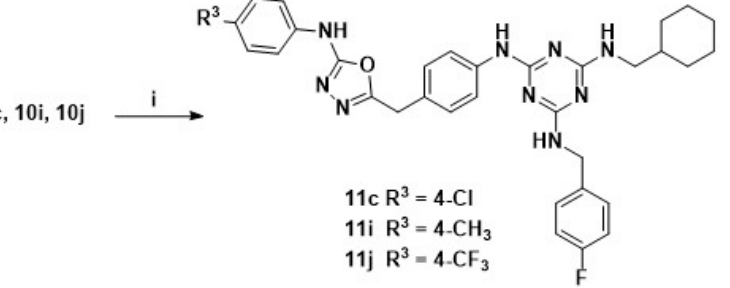
Scheme 4. Synthetic pathway for the 1,3,5-triazines derivatives 11c , 11i and 11j . Reagents and con- dition: EDC·HCl, cat. HOBt, DMF, r.t., 3–5